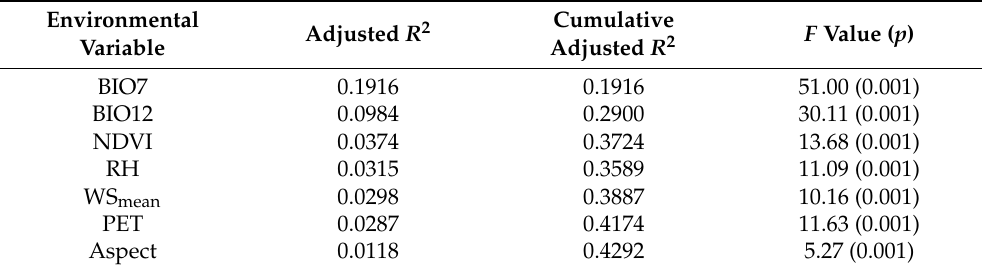
Table 4. Relative contribution (adjusted R 2 ) and F test of environmental variables explaining outlier genetic variation in Zingiber kawagoii using a forward selection